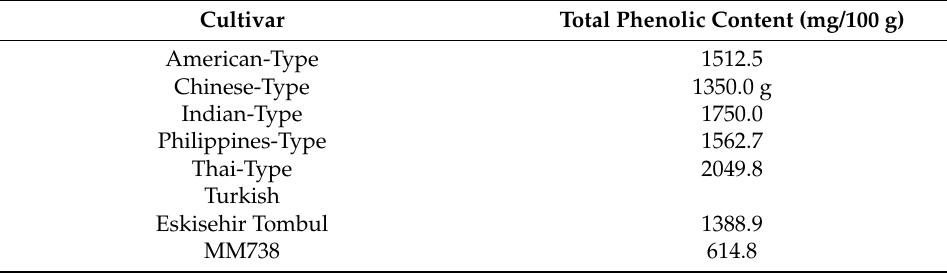
Table 8. Variations in total phenolic content in different eggplant cultivars